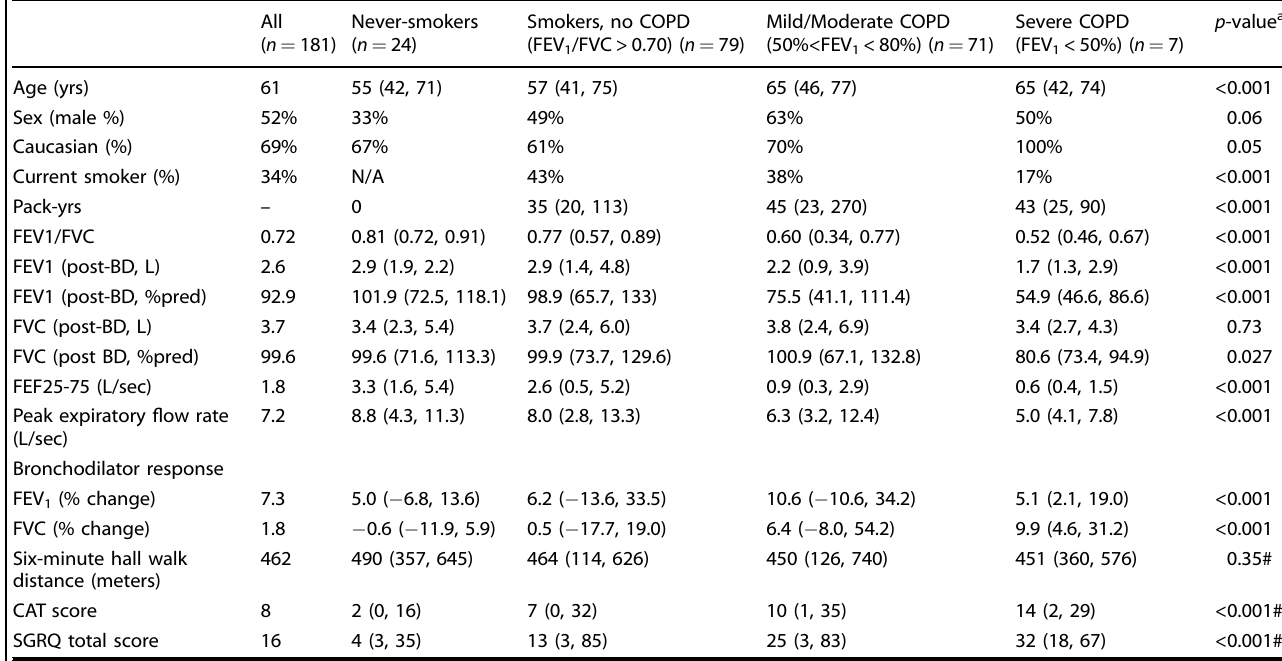
Table 1. Baseline characteristics of subjects.